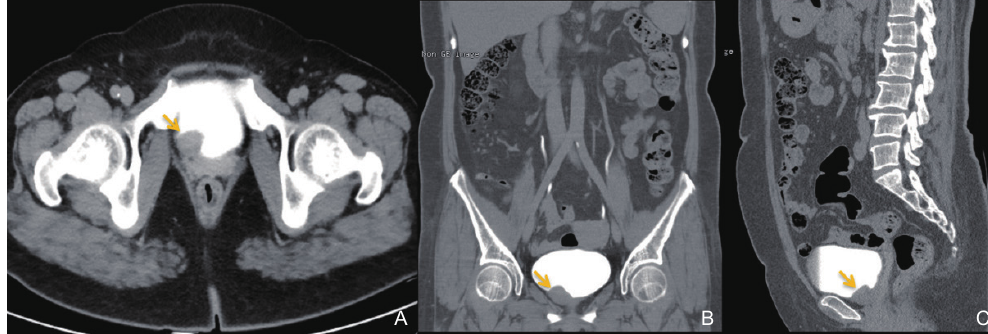
Figure 3 A bladder leiomyoma on CT of the pelvis with intravenous contrast medium, showing a well-delineated intramural bladder tumor, 2.5x2.0 cm, arising from trigone of bladder wall. There was no enhancement during venous phase. Transverse view (A), coronal view (B), sagittal